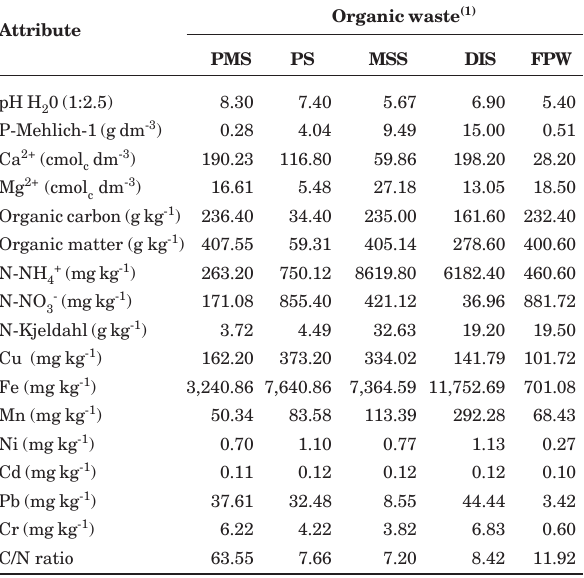
Table 2. Chemical properties of organic wastes used in the experimental